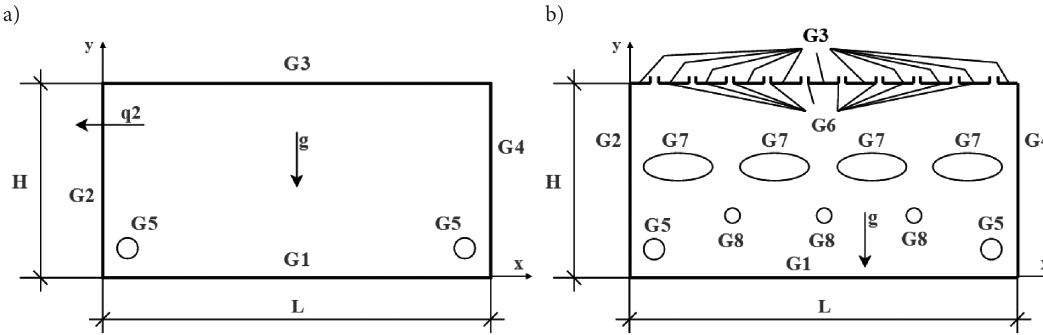
Figure 3. Closed-rated (a) and unclosed-rated (b) operating zones for air